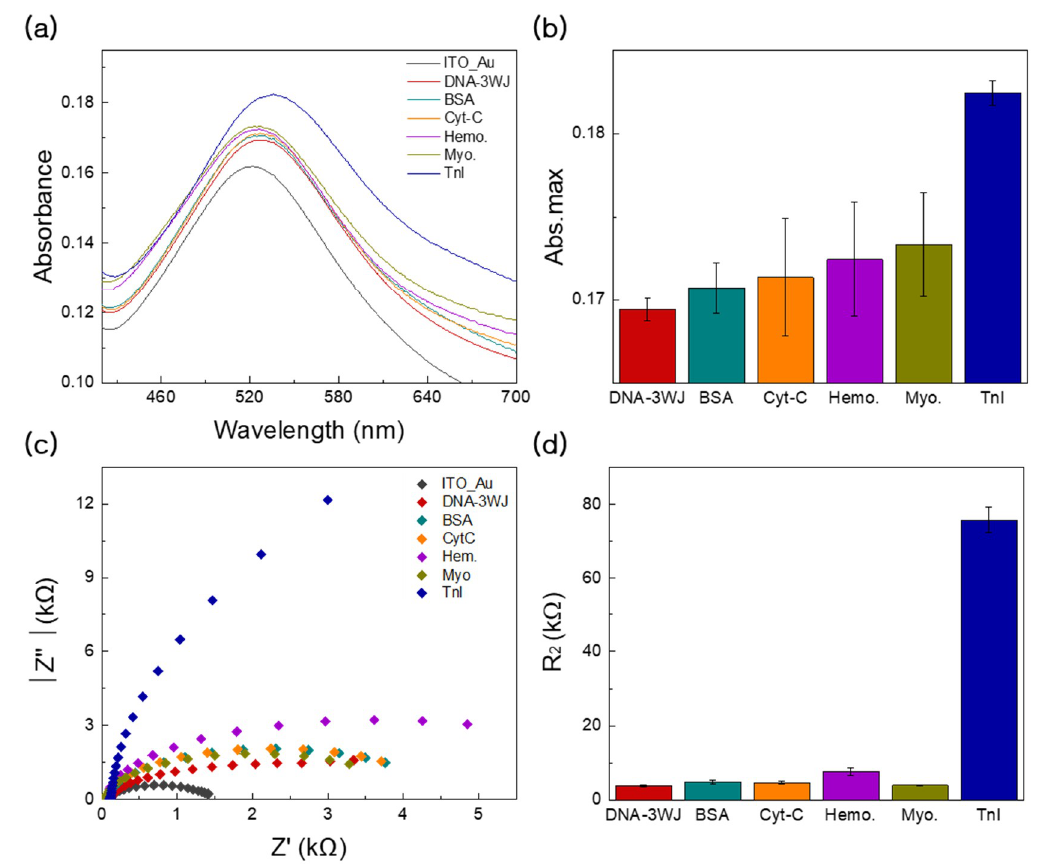
Figure 6. ( a ) Selectivity test of DNA 3WJ / AuNC-based with the various targets including BSA (turquoise line), cytochrome c (yellow line), hemoglobin (purple line), myoglobin (grass line) and cTnI (blue line) through LSPR. ( b ) Change in absorbance peak based on selectivity test with other protein reaction. ( c ) Selectivity test of DNA 3WJ / AuNC-based with the various targets including BSA (turquoise line), cytochrome c (yellow line), hemoglobin (purple line), myoglobin (grass line) and cTnI (blue line) through EIS. ( d ) Change in resistance based on selectivity. Error bar represents relative standard deviation of eight independent